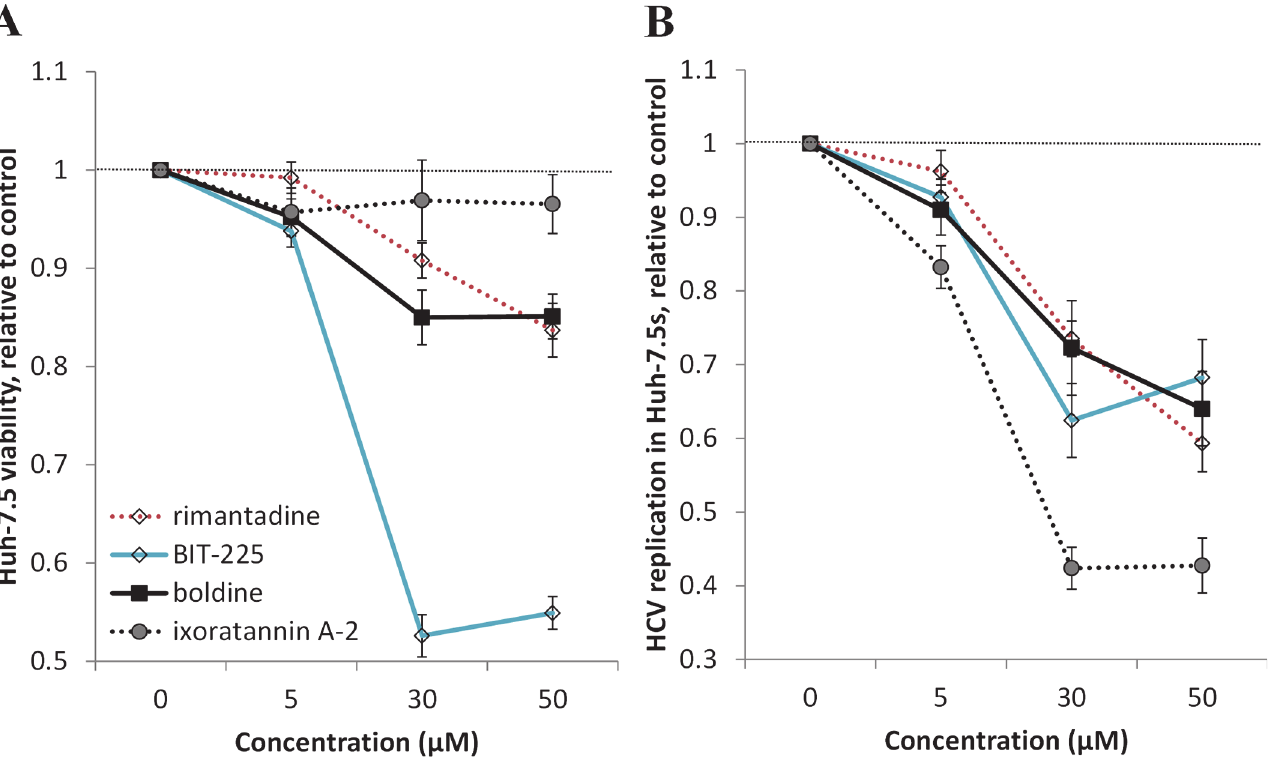
Fig 6. Effects of compounds on HCV replication. A, Cell viability at 72 h post-infection in the presence of compounds at defined concentrations. Data are normalized to the percent of viable cells in a HCV-infected culture plus 0.1% DMSO. B, HCV replication at 72 h post-infection in the presence of compounds. Data are normalized to percent HCV-infected cells plus 0.1%